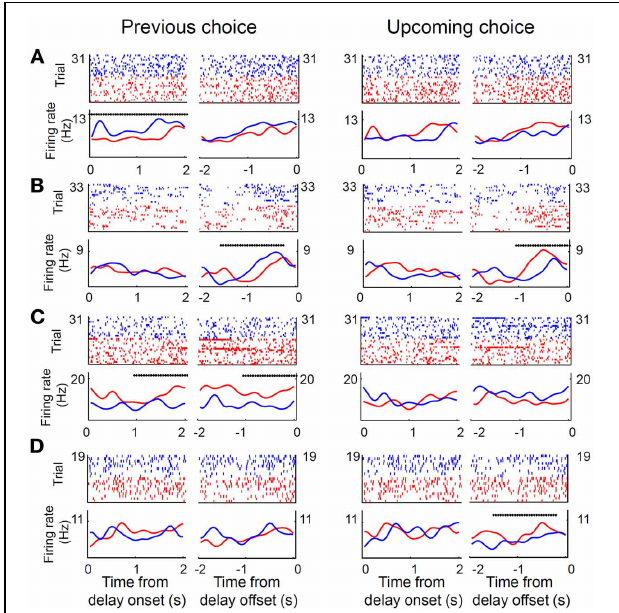
FIGURE 5 | Examples of MDN neural activity during delay period. (A–D) Shown are four unit examples. Trials were divided into two groups according to the previous (left panel) or upcoming (right panel) goal choice (red, left goal choice; blue, right goal choice). Top, spike raster plots. Each tick mark indicates a spike and each row is one trial. Each trial was aligned to the onset or offset of the delay period. Bottom, spike density functions that were generated by applying a Gaussian kernel ( σ = 100ms) to the corresponding spike trains in the raster plots. Asterisks denote significant dependence of unit activity on the animal’s previous (left panel) or upcoming (right panel) goal choice (Equation 1) during a 1-s time window (asterisk aligned at the center of the window) that was advanced in 50-ms time